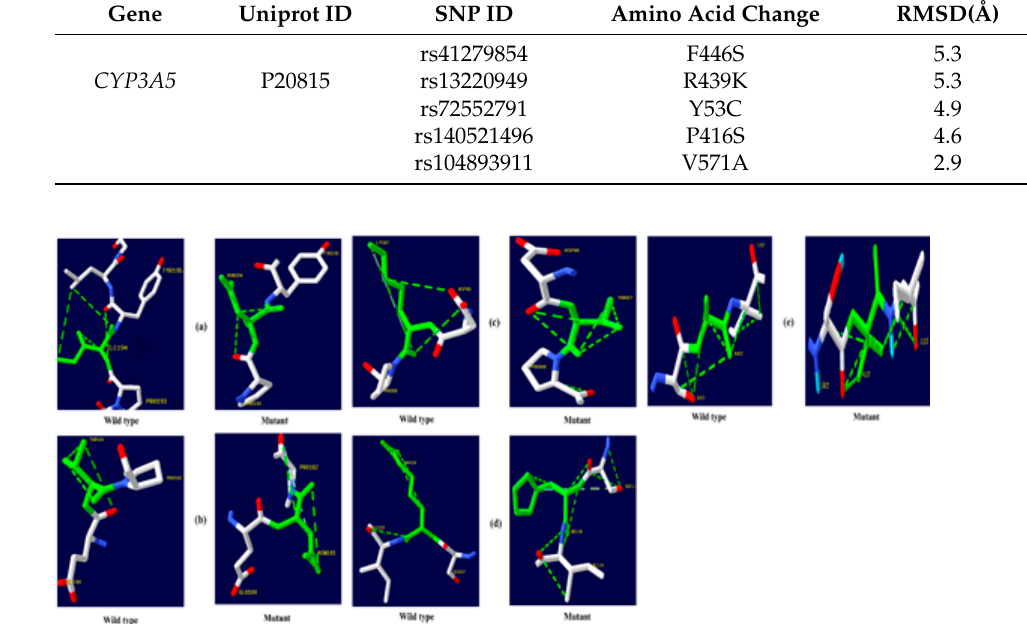
Table 4. RMSD value of CYP3A5 protein.